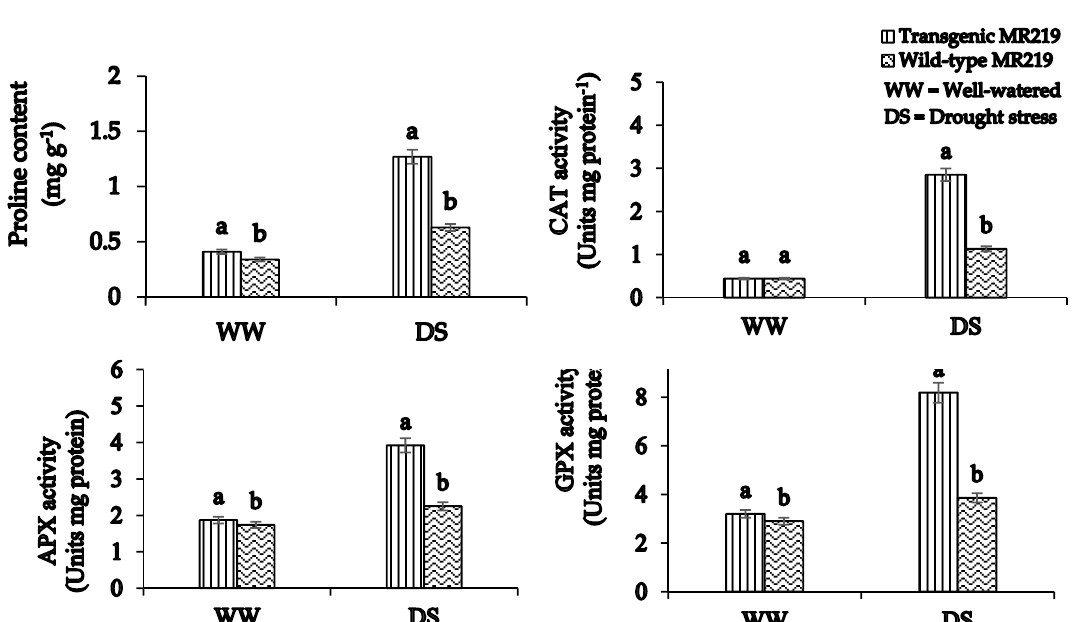
Figure 2. E ff ects of drought stress treatment on proline, CAT, APX, and GPX activities in rice genotypes. Vertical bars represent standard error of the mean. Values within drought stress treatment with the di ff erent letters (a and b) are significantly di ff erent based on comparison using DNMRT at p ≤ 0.05 ( n =